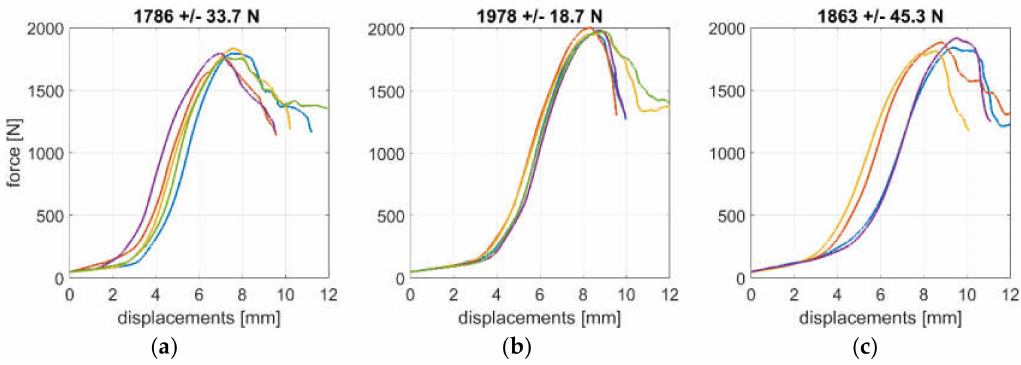
Figure 2. Example measurements from a box compression test machine [29] for di ff erent